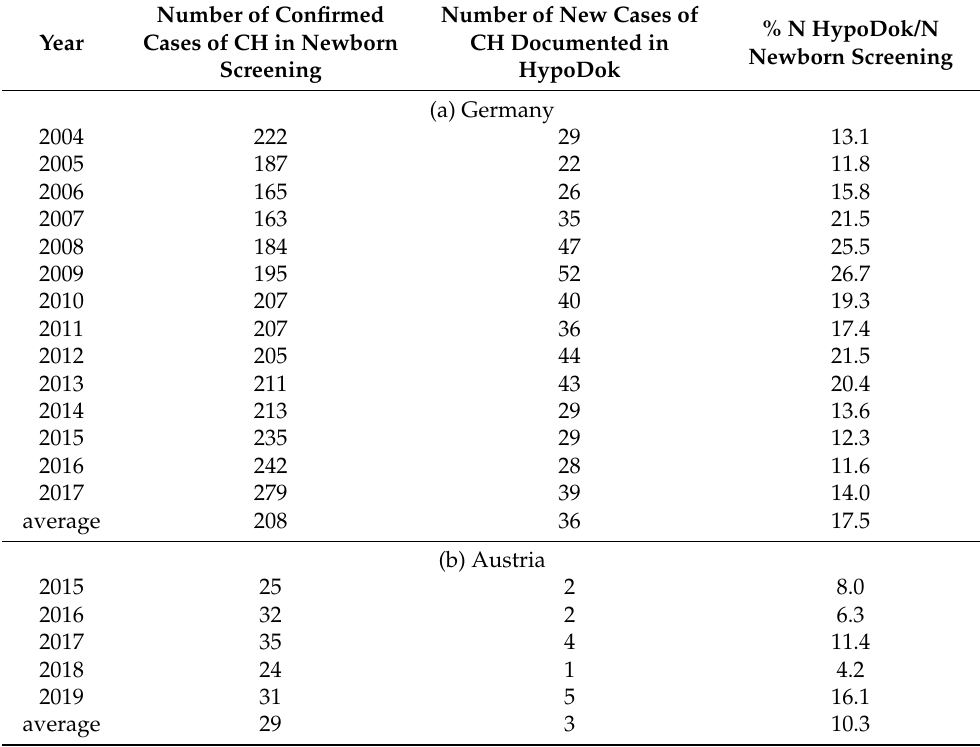
Table 3. Comparison of official number of CH newborn diagnoses per year in newborn screening and documentation in HypoDok for (a) Germany [3] and (b) Austria [17].